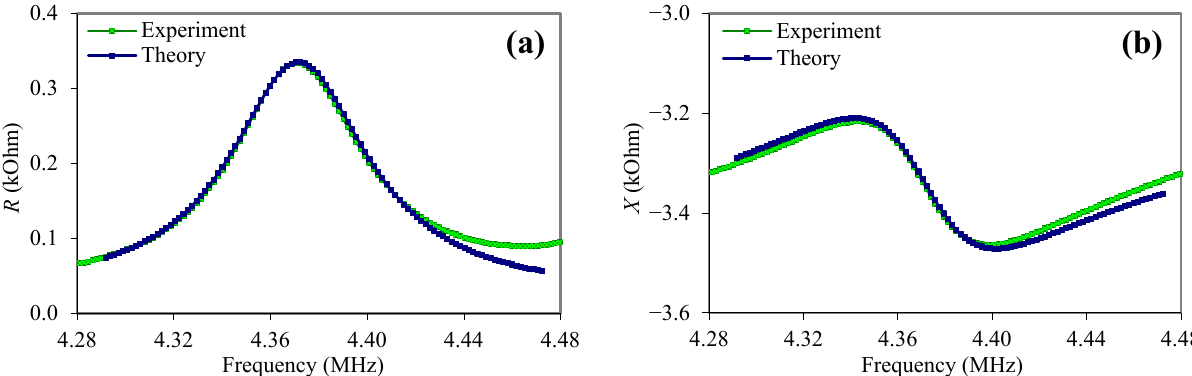
Figure 8. Frequency dependences of the real ( a ) and imaginary ( b ) parts of the electrical impedance of the quartz resonator loaded on both sides with glycerol (blue color—theory; green color—experiment).